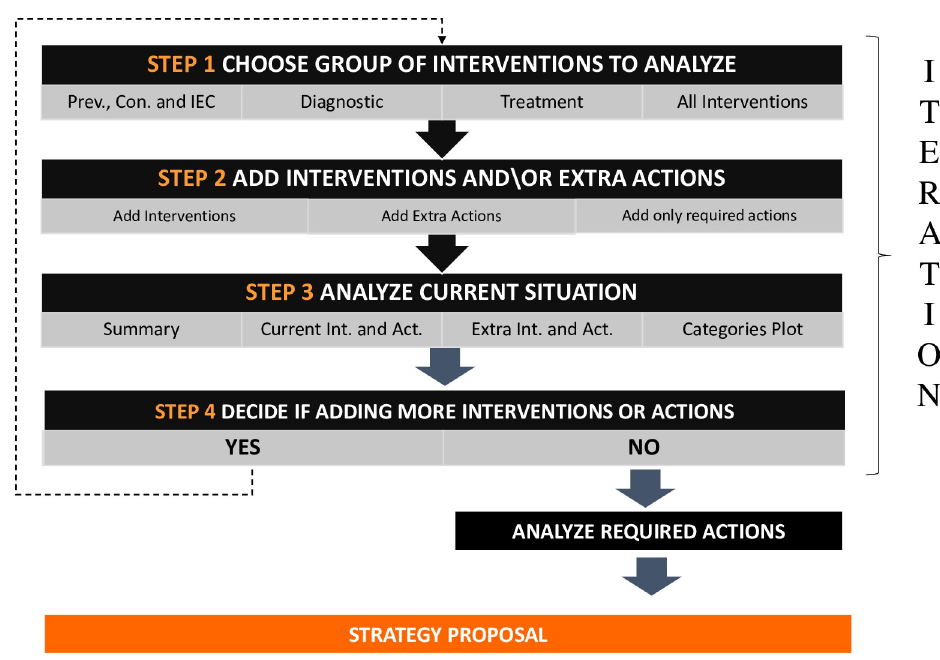
Fig 2. Iterative process step by step to select Actions and